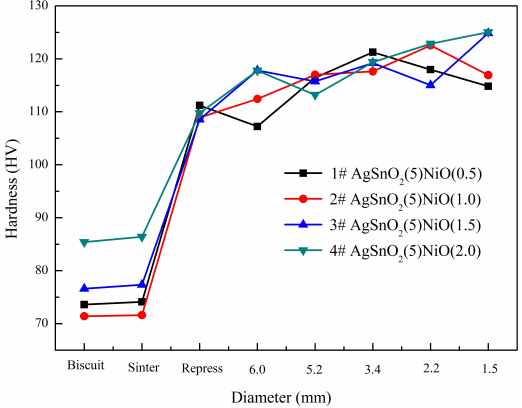
Figure 8: The chart of AgSnO 2 NiO samples’ elongation and